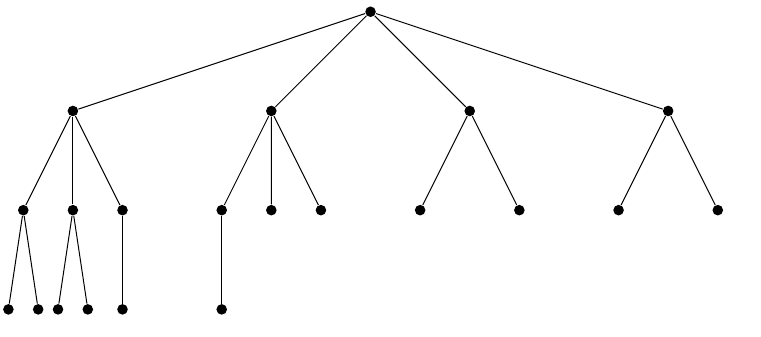
Figure 2: A greedy tree with degree sequence (4 , 4 , 4 , 3 , 3 , 3 , 3 , 2 , 2 , 1 , 1 , . . . , 1)